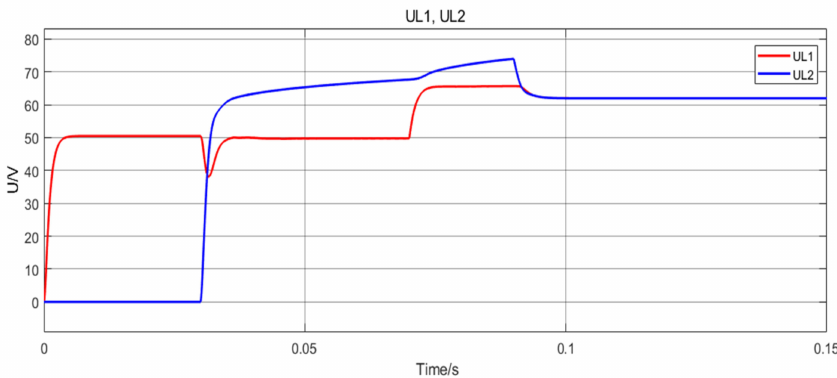
Figure 10. Simulation diagram of output voltage change of load #1 and load #2.